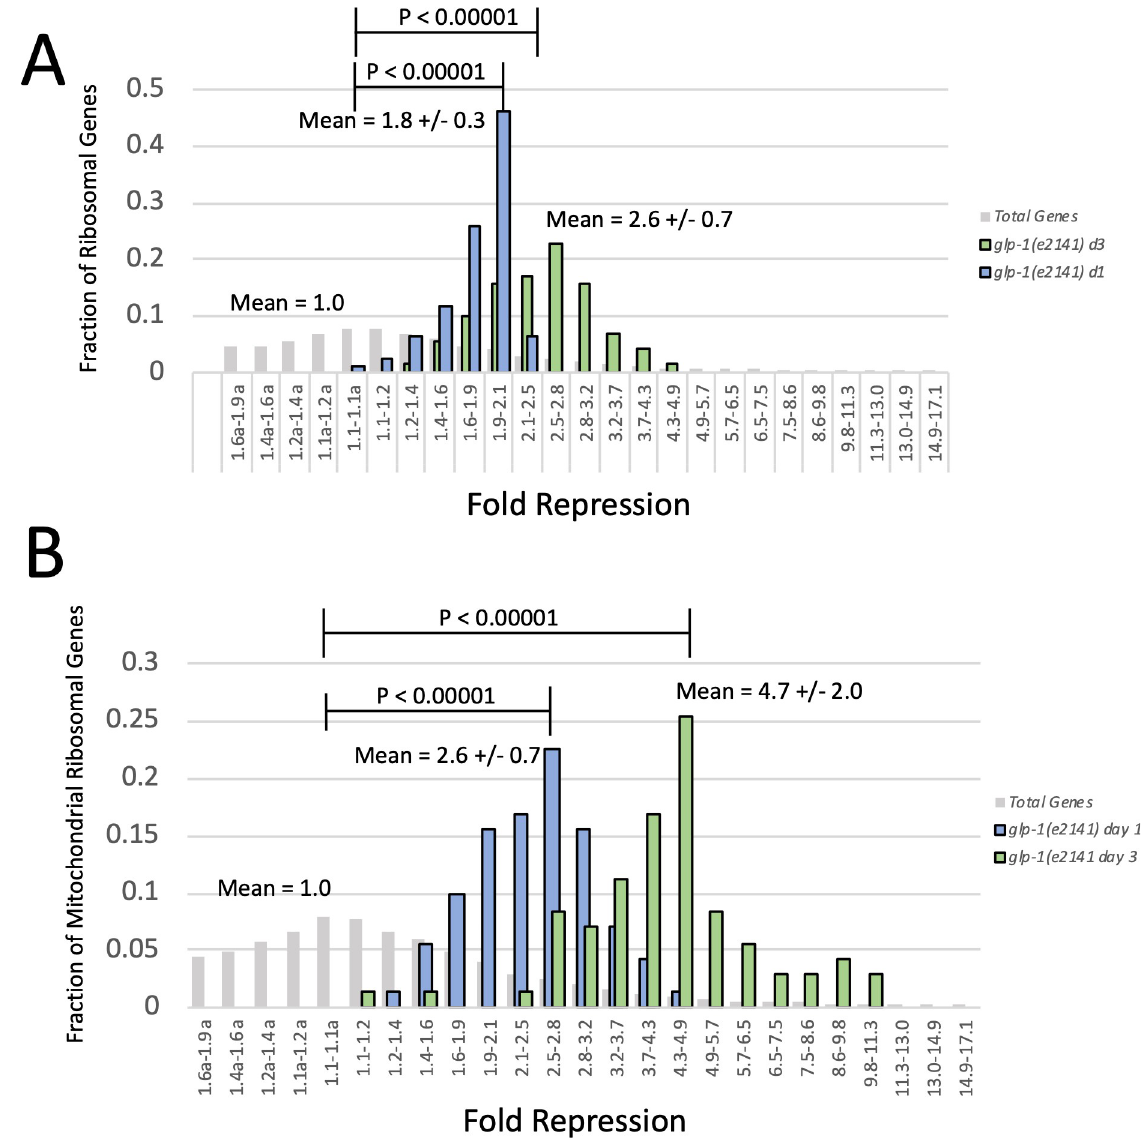
Fig 4. Ribosomal Protein Genes (RPGs) are Repressed in glp-1(e2141) Adults. (A) Histograms of cytosolic ribosomal protein genes (cRPGs) binned by fold repression/activation. Activation is indicated on the x-axis by an (a) next to the bin range. Data represent the fraction of total cytosolic ribosomal protein genes residing in each range of repression. Blue bars represent repression between L4 and day 1 of adulthood and green bars represent repression between L4 and day 3 of adulthood. Gray bars represent the fraction of total genes in each range of repression or induction. Mean is the average repression of all cRPGs at day 1 or day 3 of adulthood along with the standard deviation. Data show that cRPGs are repressed together (as indicated by tight distributions) in day 1 adults by an average of 1.8-fold and further repressed together in day 3 adults by an average of 2.6-fold. The repression of cRPGS at both day 1 and day 3 of adulthoods is highly significantly in comparison to total genes (P value < 0.00001). (B) Histograms of mitochondrial ribosomal protein genes (mRPGs) binned by fold repression/activation. Blue bars represent the repression of mitochondrial ribosomal protein genes between L4 and Day 1 of adulthood, and green bars represent the repression of mRPGs between L4 and day 3 of adulthood. Gray bars represent the fraction of total genes in each range of repression or induction. Mean is the average repression of all mRPGs at day 1 or day 3 of adulthood along with the standard deviation. Data show that mRPGs are repressed together in day 1 adults by an average of 2.6-fold and further repressed together in day 3 adults by an average of 4.7-fold. Repression of mRPGs is significantly stronger than cRPGs (P-value < 0.00001). The repression of mRPGs at both day 1 and day 3 of adulthoods is highly significantly in comparison to total genes (P value < 0.00001). RNAseq data were derived from 5 biological replicates. Statistics were calculated using a T-test for two independent means. E.g., the mean of cRPGs vs the mean of total genes.